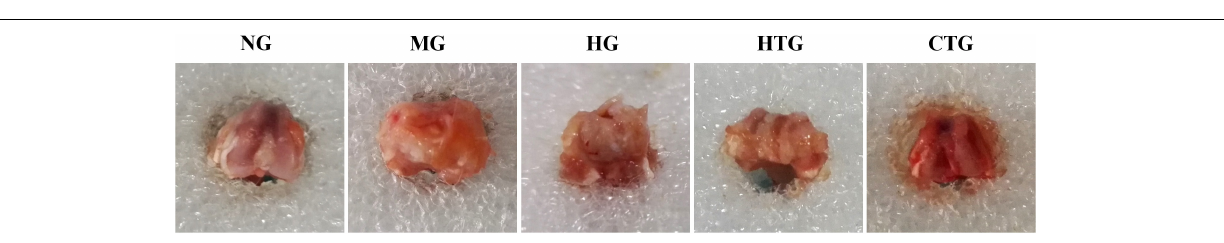
FIGURE 4 | Gross observations of knee joint cartilage repair of rat OA models after 56 days of treatment. NG, LG-DMEM; MG, Model group; HG, 0.05 mg/mL HA; HTG, hAMSCs 1 × 10 6 ; CTG, HA (0.05 mg/mL) + hAMSCs (1 × 10 6 ). This figure shows the representative rat joints of each group containing six